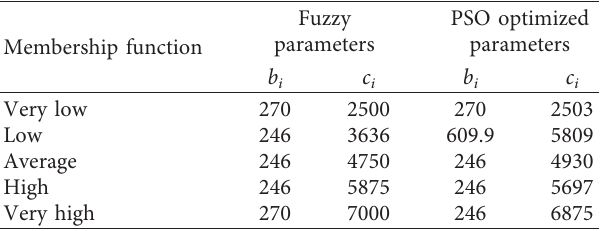
Table 5: Fuzzy-PSO optimized result of historical load for microgrid model.